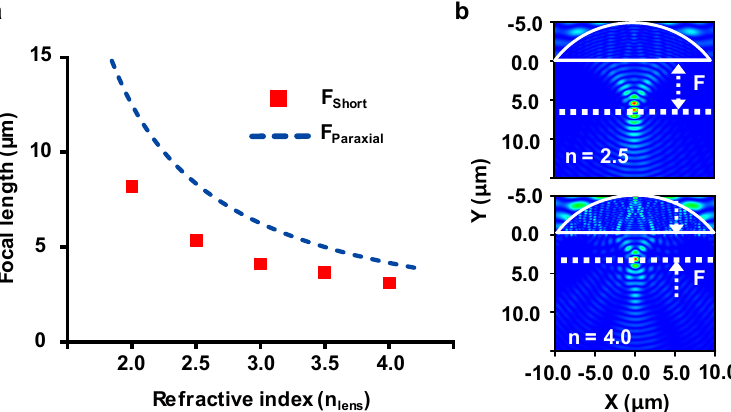
Figure 3. ( a ) Plot of focal length vs. µ-SIL refractive index. The line shows data calculated by geometrical optics and the red markers are the results from FDTD simulation. ( b ) E-field intensity distribution of plane wave illumination onto µ-SILs with different refractive indices, n = 2.5 (upper) and n = 4.0 (lower).